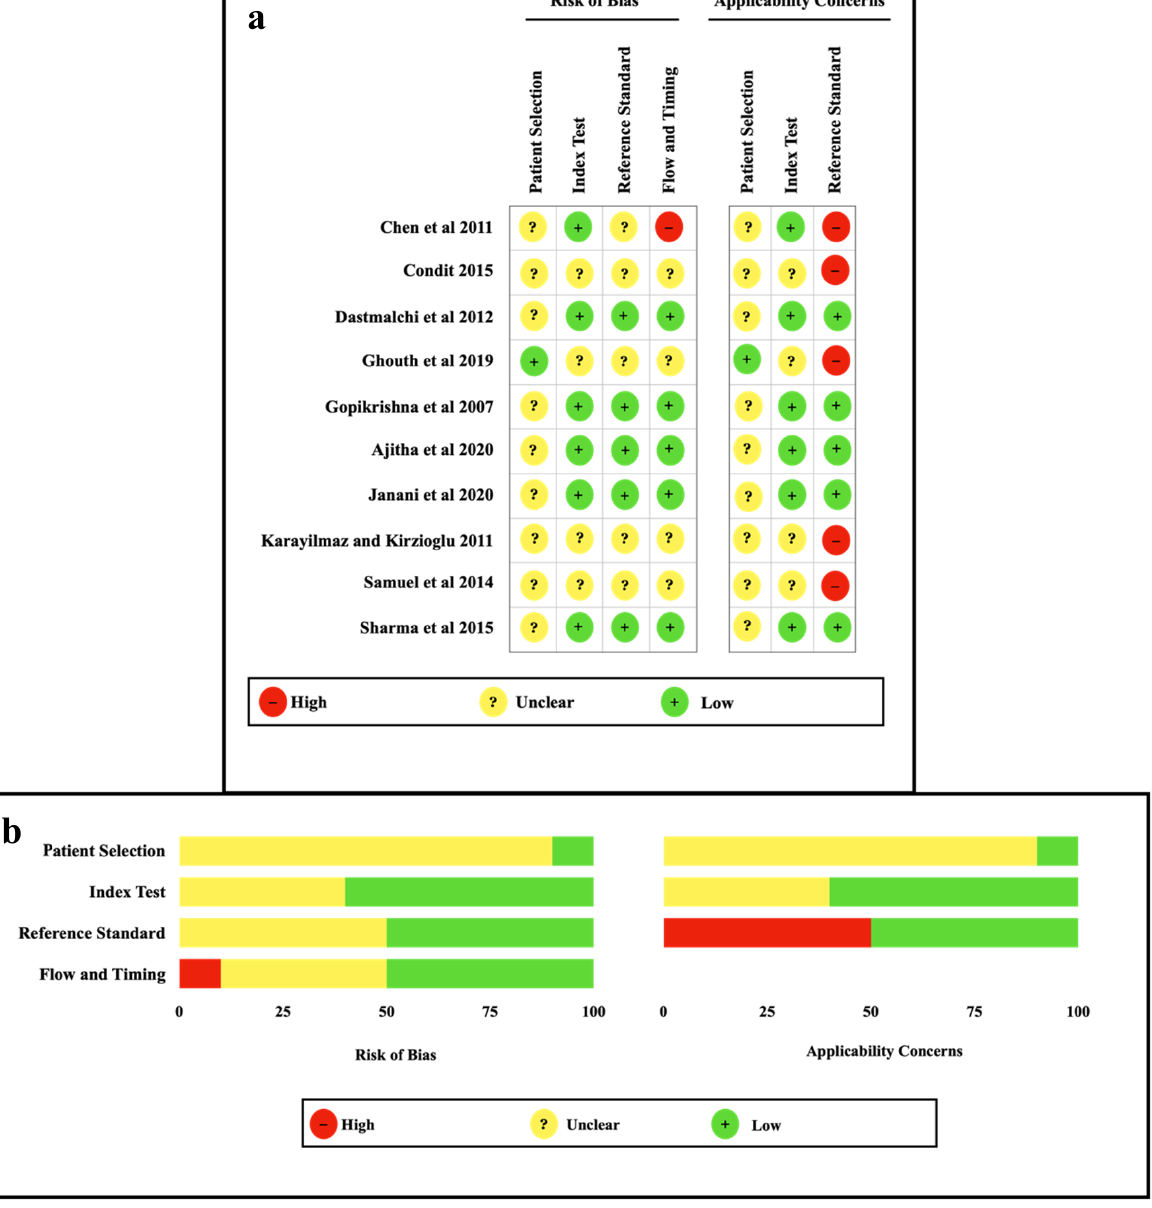
Figure 2. The quality assessment results of the included studies [7,10–12,16,25–29]. ( a ) Individual studies and ( b ) Within studies.